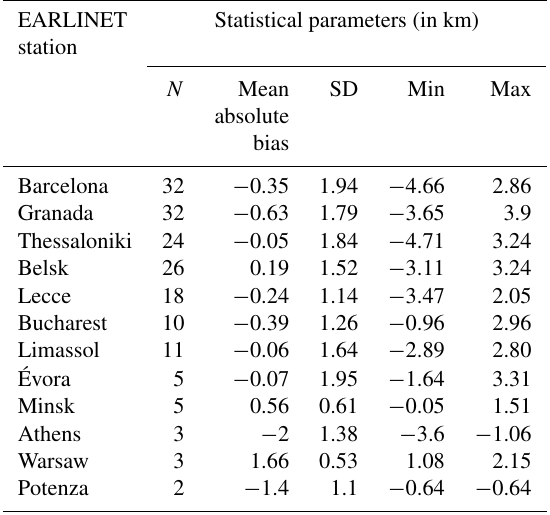
Table 5. Summary of statistics for the comparisons between GOME-2 AAH and LIDAR ALH for all stations ∗ sorted by maxi- mum number of collocations